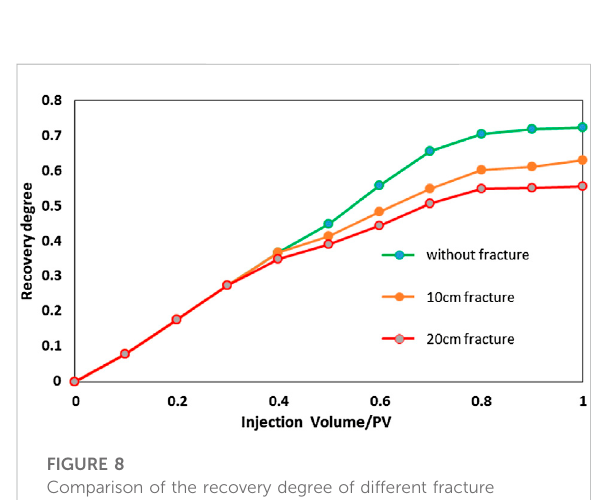
FIGURE 9 Pressure distribution at different